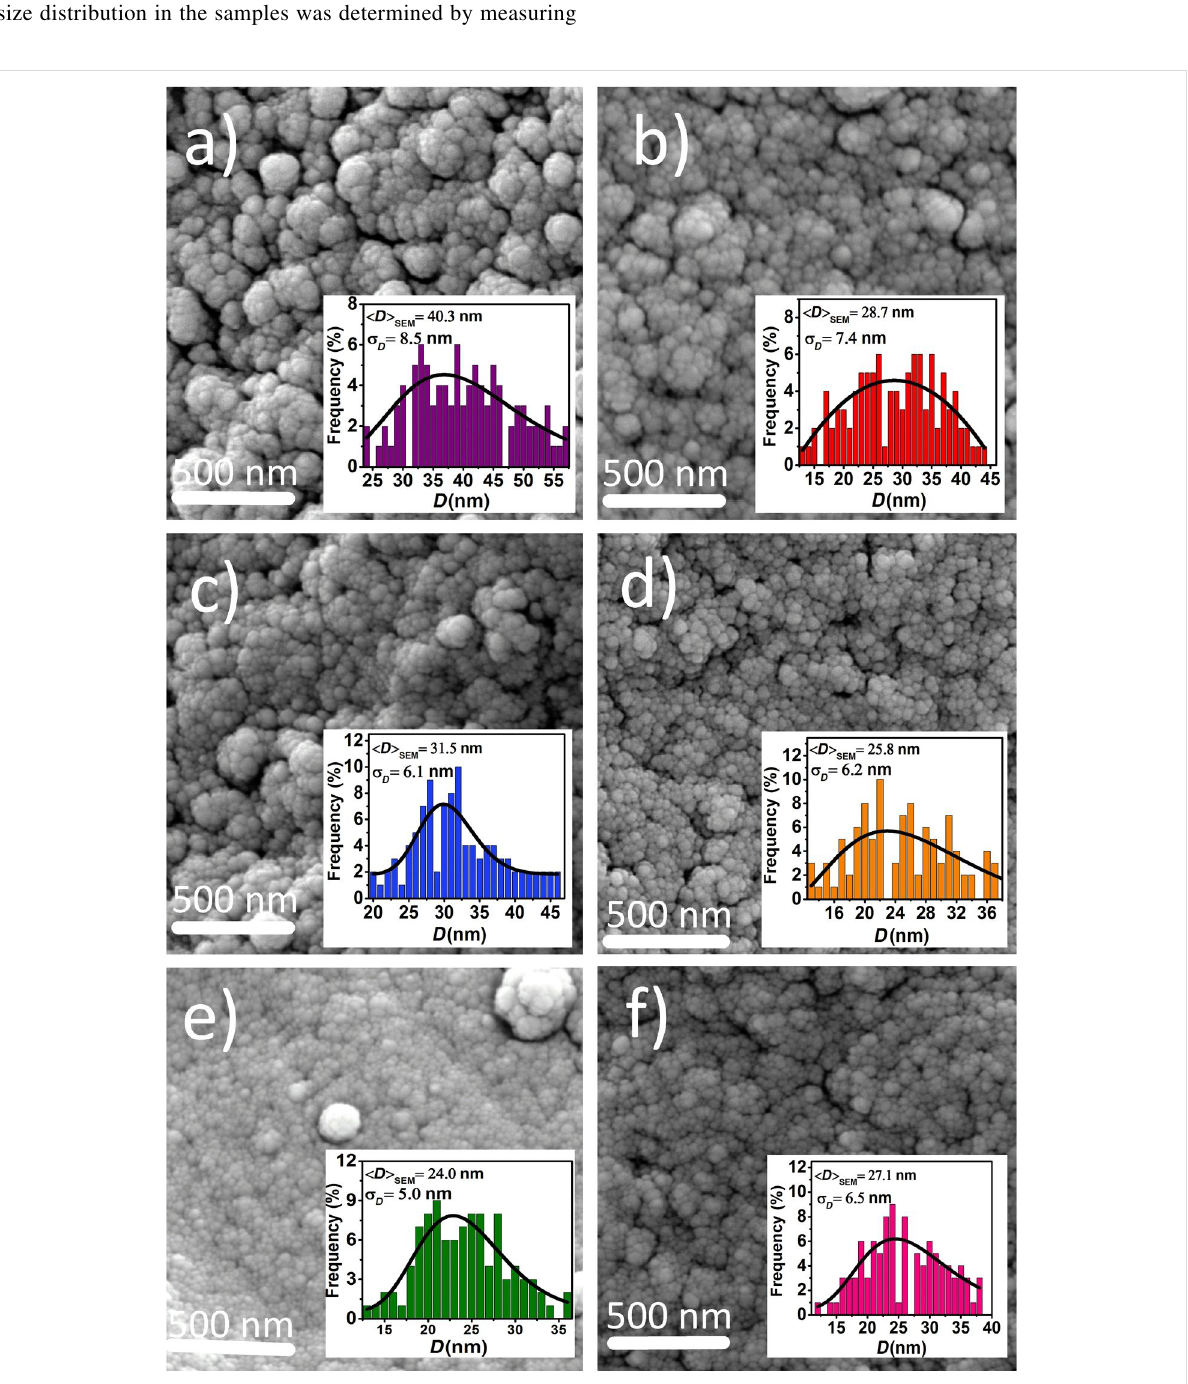
Figure 3: FE-SEM images of Co x Fe 3 − x O 4 nanoparticles: (a) x = 0.0; (b) x = 0.2; (c) x = 0.4; (d) x = 0.6; (e) x = 0.8 and (f) x = 1.0. Insets show the par- ticle size distribution fitted with a log-normal function (solid line).